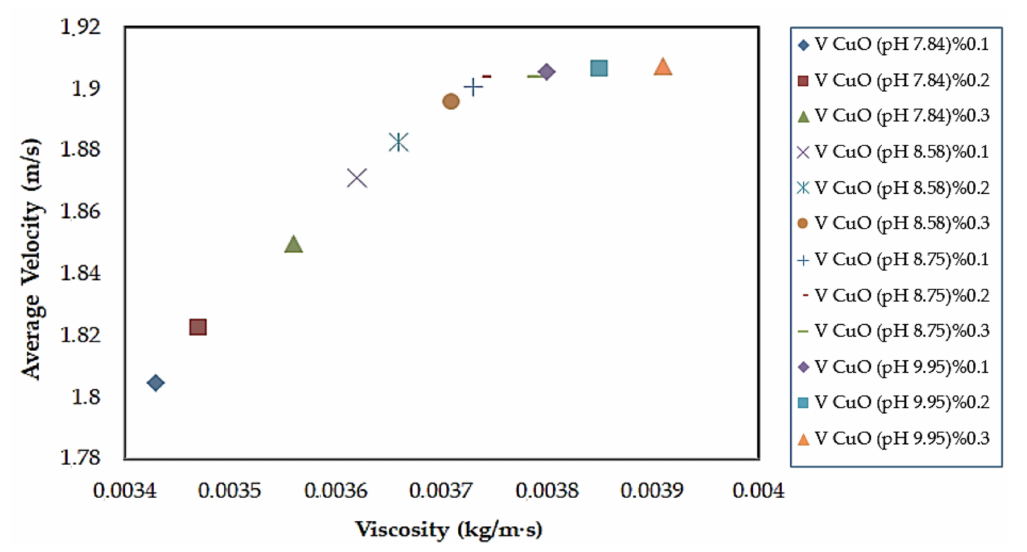
Figure 7. The average velocity-viscosity change of nanofluids obtained at different pH and CuO